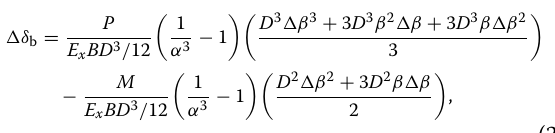
Since Δ δ is the deformation in the range of D Δ β , the notch at the top of the beam end has no effect on the